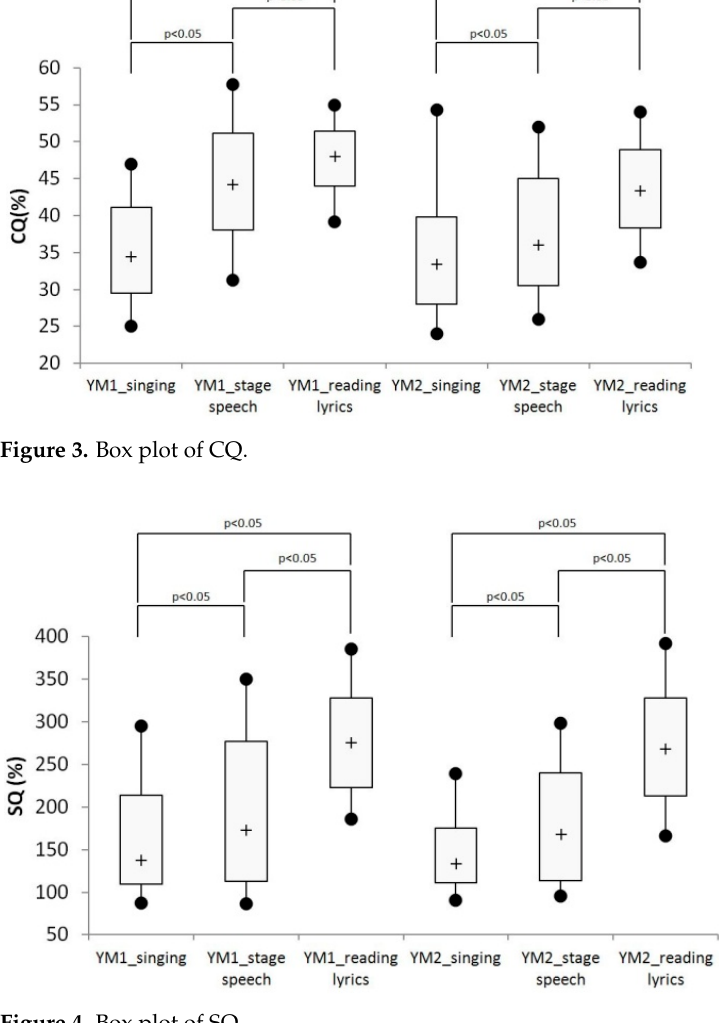
Figure 4. Box plot of SQ.